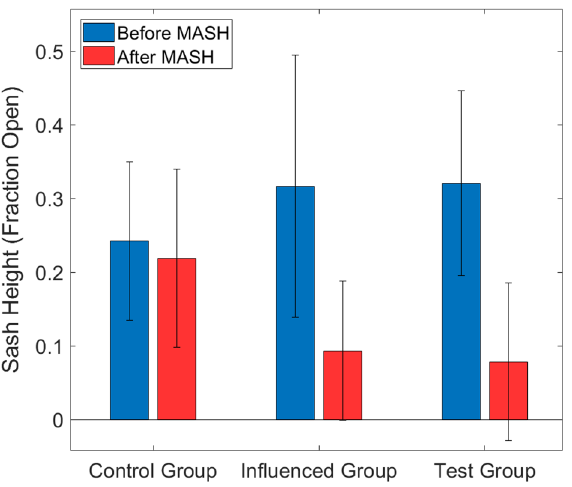
Figure 6. Summary of results. Average sash heights are shown before and after MASH installation, with error margins based off of a 95% confidence interval. The average sash height decreased among all groups. With the 95% confidence interval, the test group’s average sash height decreased with statistical significance (described in the Supplementary Information, Section